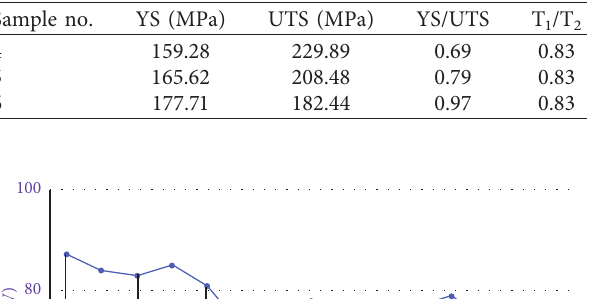
Figure 5: Macrostructure of sample 4, underwater welded speci- men joined at 1000 rpm, 36mm/min.